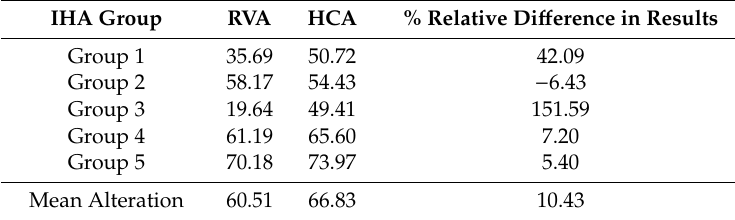
Table 7. Comparison of group mean and final mean alteration for the RVA and HCA method.